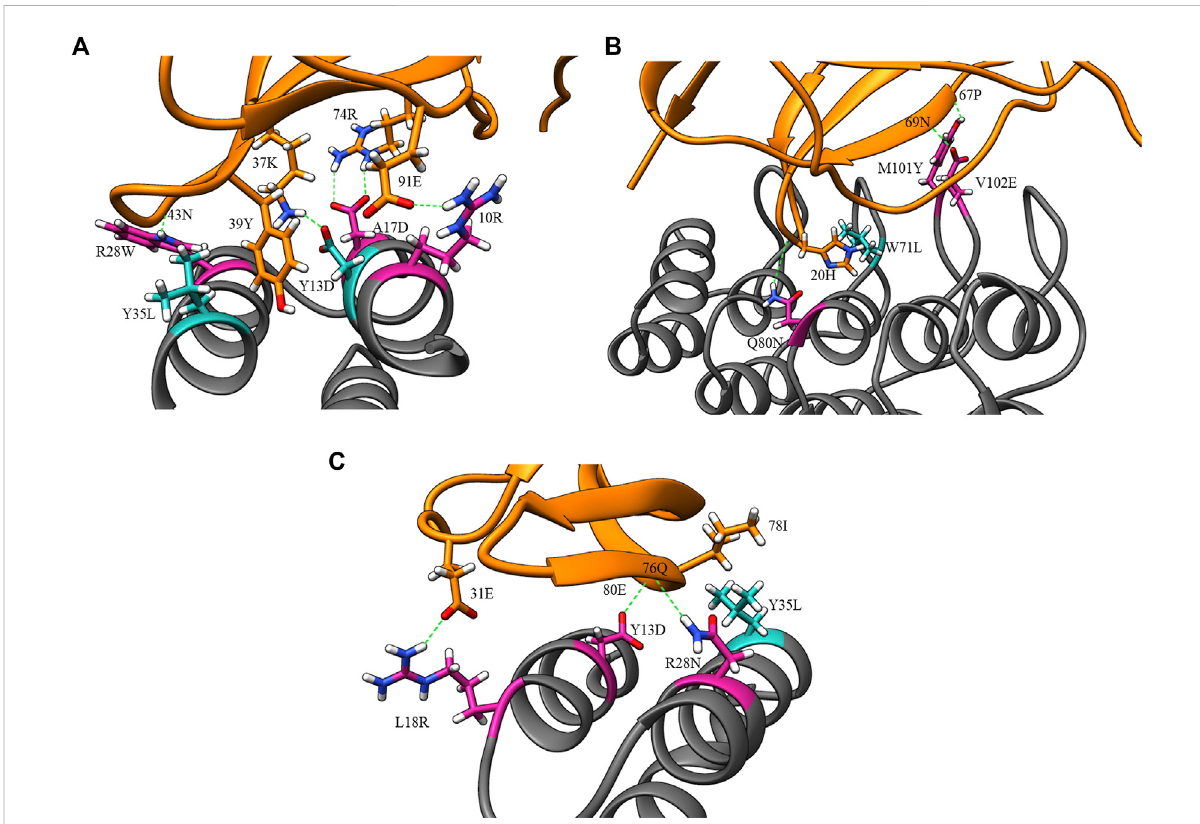
FIGURE 5 Example design and clash mutations in three MutDock designs. Design mutations are shown in pink, clash mutations are shown in dark cyan, and H-bonds are shown in broken green lines. (A) 1JRH-af fi body. Native residue 10ARG and design mutations ARG28TRP andALA17ASP make H-bonds with 91GLU, 43ASN, and 46TRP, respectively. Clash mutation TYR13ASP makes H-bond with 37LYS. Clash mutation TYR35LEU makes hydrophobic interaction with 39TYR. (B) 4AL8-DARPin. Design mutations VAL102GLU, GLN80ASN, and MET101TYR make H-bonds with 69ASN,20HIS,and67PRO,respectively.ClashmutationTRP71LEUmakeshydrophobicinteractionwith20HIS. (C) 3BDY-af fi body.Designmutations ARG28ASN,TYR13ASP,andLEU18ARG makeH-bondswith 76GLN, 80GLU,and 31GLU,respectively. ClashmutationTYR35LEU makes hydrophobic interaction with 78ILE.